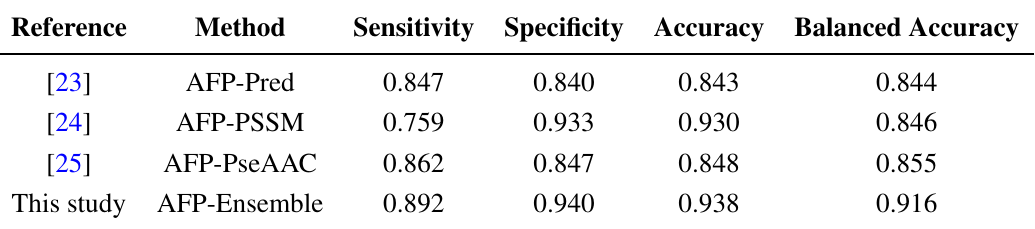
Table 5. The prediction results compared to those of other methods on the independent testing dataset. Pred, prediction; PSSM, position-specific scoring matrix; PseAAC, pseudo amino acid